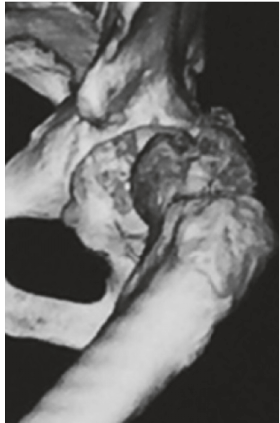
Figure 3: Computed tomography of the left hip joint after redislo- cation.